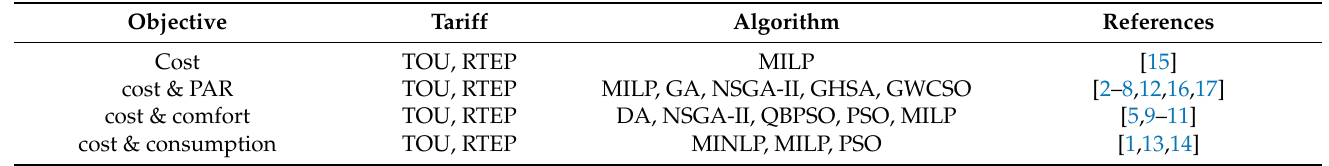
Table 1. Summary in terms of objectives, tariffs, and methods of investigated literature.